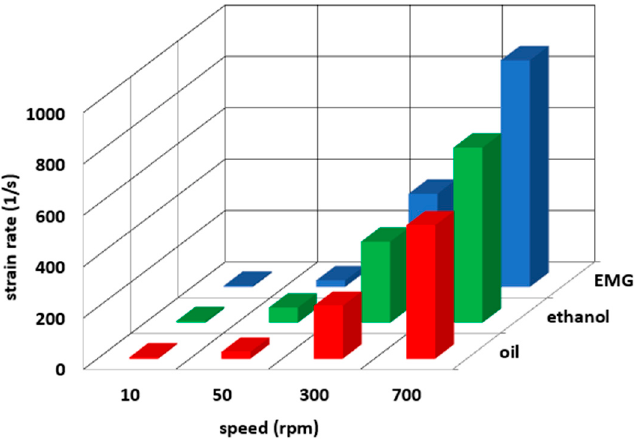
Figure 12. Mean strain rate for different variants of the numerical calculations.